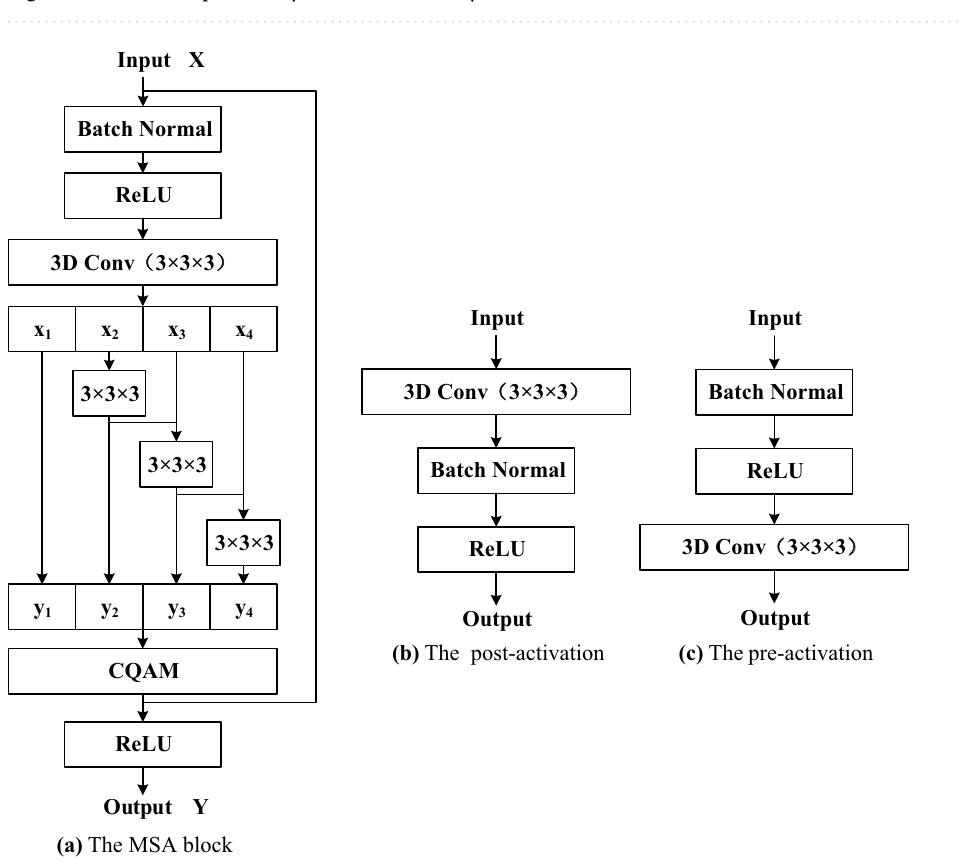
Figure 2. The structures of the MSA block, post-activation and